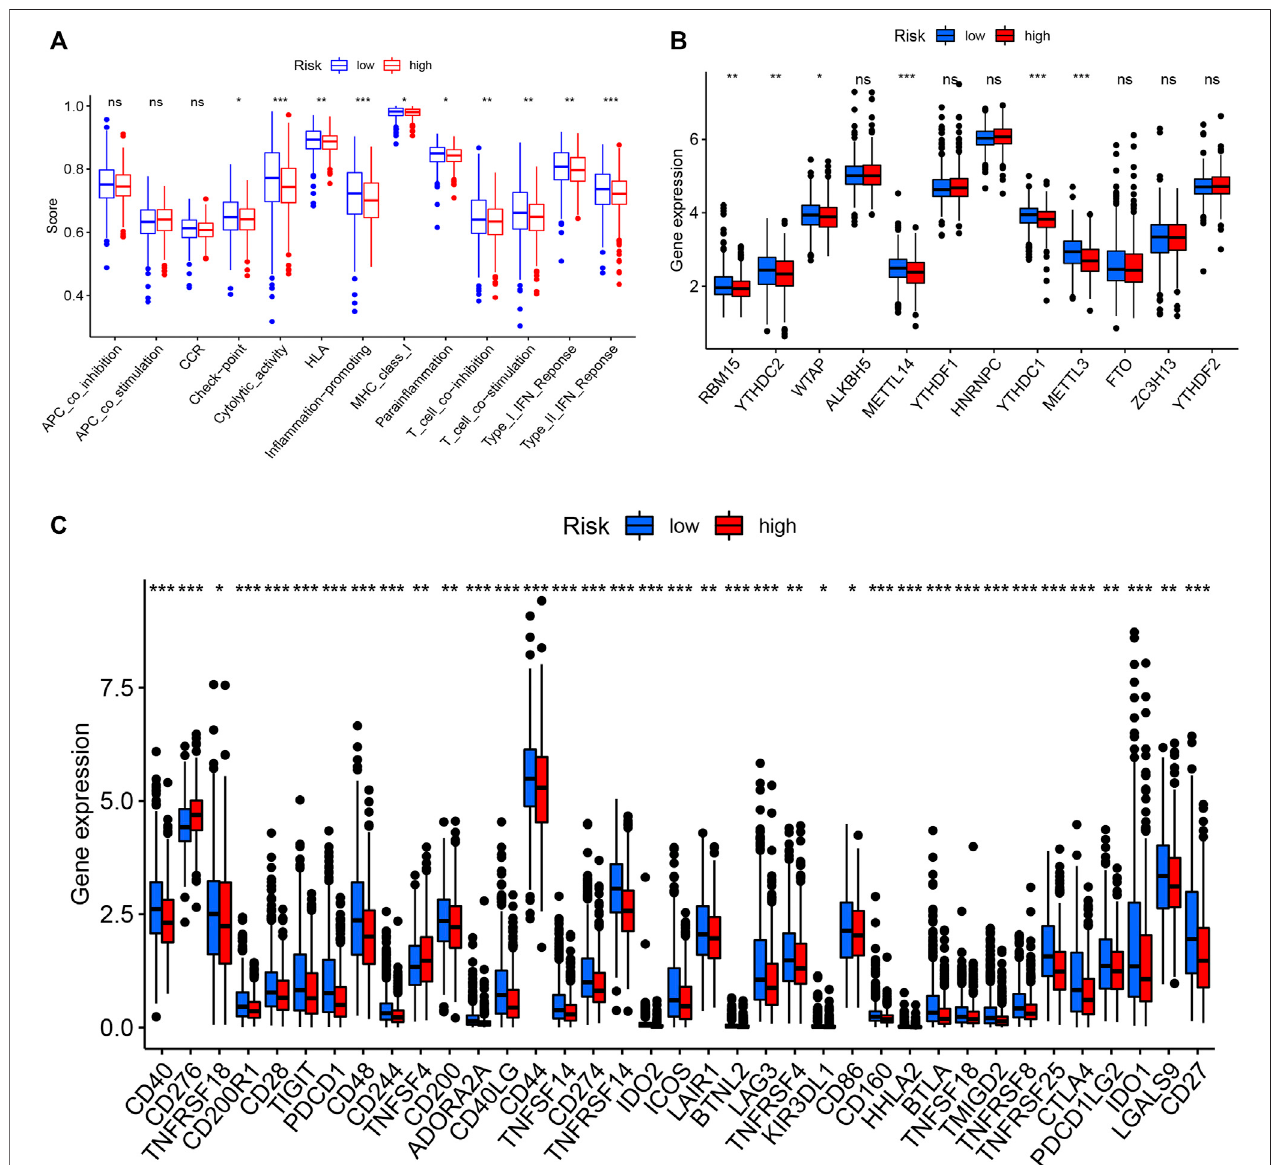
FIGURE8| Immune cellin fi ltration levelsandcorrespondingfunctiondetermined byssGSEA (A) .Expressionofm6A-related genesinbothgroups (B) .Expression of immune checkpoint-related genes in both groups (C) .